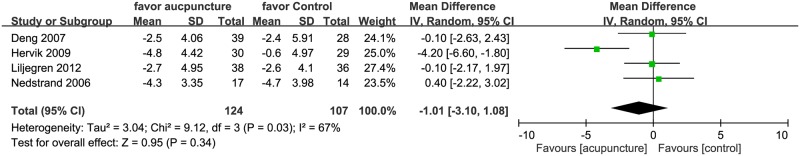
Forest plot of the effect of acupuncture on the frequency of hot flush.(times/day).